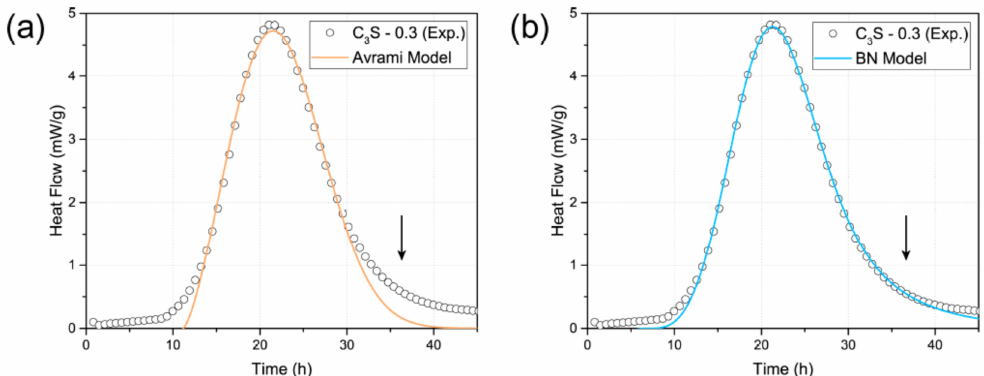
Figure 2. Fitting results of isothermal calorimetry data ( models of (a) Avrami and (b) BN. Exp.: Experimental